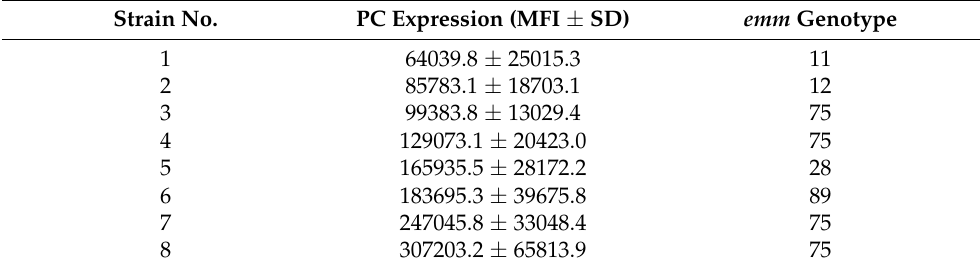
Table 1. PC expression and emm genotype on Streptococcus pyogenes . Strain